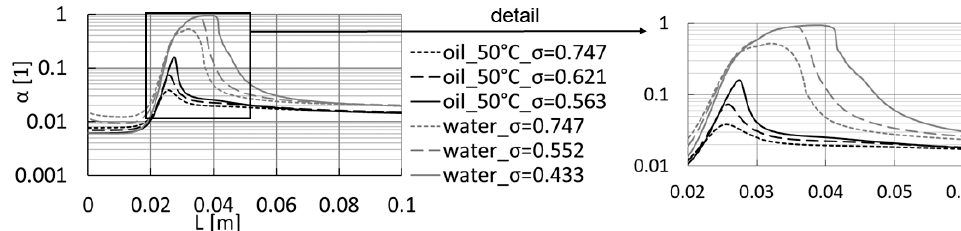
Figure 11. Dependence of volume fraction of gas 𝛼 (1) vs. length 𝐿 (m); the detail is to the right. Figure 12 gives the photographs of instantaneous gas clouds in the measurements. Simulated results are time-averaged. These experimental results document the distribution of gases in the cavitation region in accordance with Figures 10 and 11. The modeled and experimentally determined areas of cavitation roughly agree.